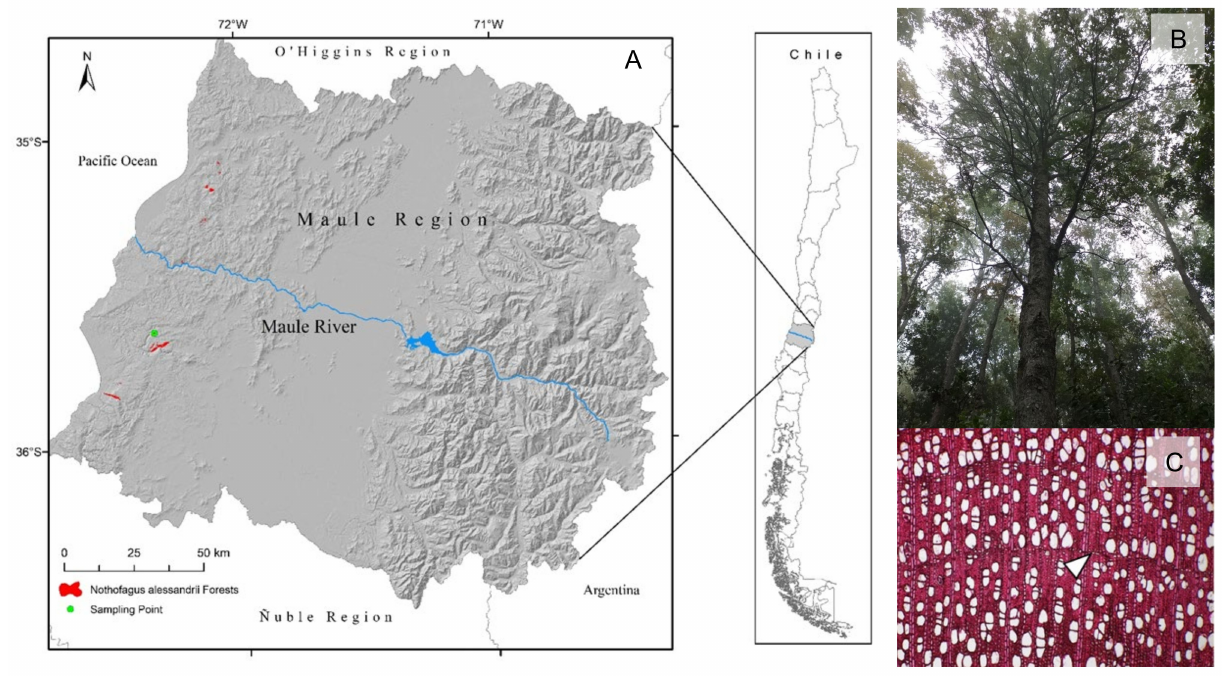
Figure 1. ( A ) Current distribution of N. alessandrii and location of studied population; ( B , C ) N. alessandrii trees and the anatomical structure of annual tree